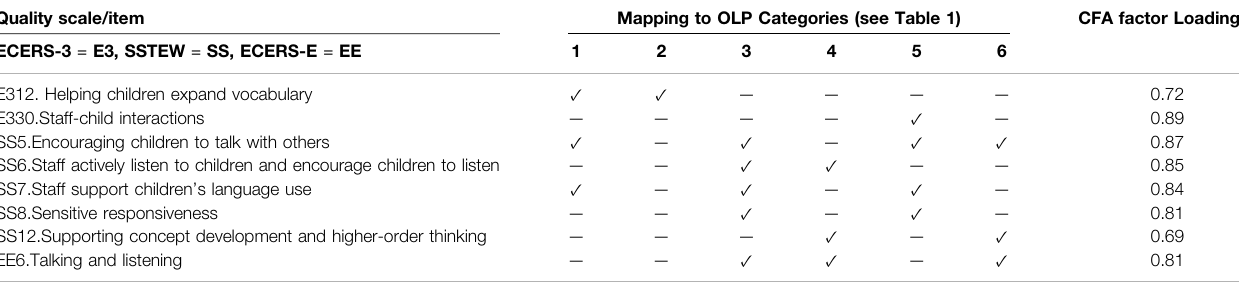
TABLE 4 | The Oral Language Quality Score: items, alignment with the OLP, and CFE factor loadings. Quality scale/item Mapping to OLP Categories (see Table 1)